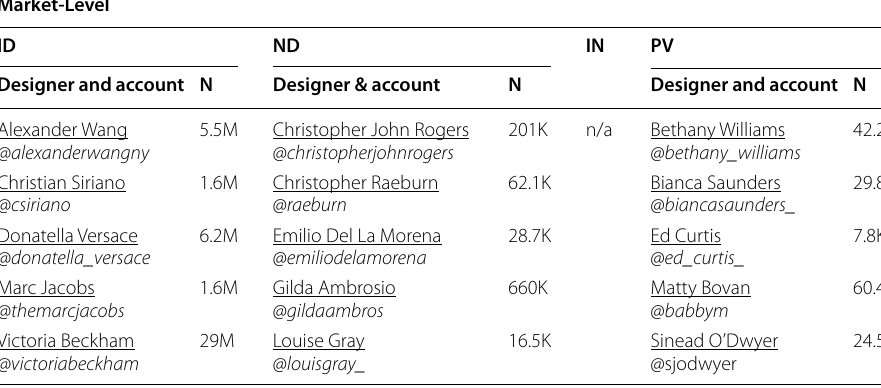
ID: International designer brands; ND: National/local designer brands; IN: International name brands; PV: Private label brands/@ username —IG handle; n/a: Not applicable; N: Number of followers; M: Million; K: 1000 followers